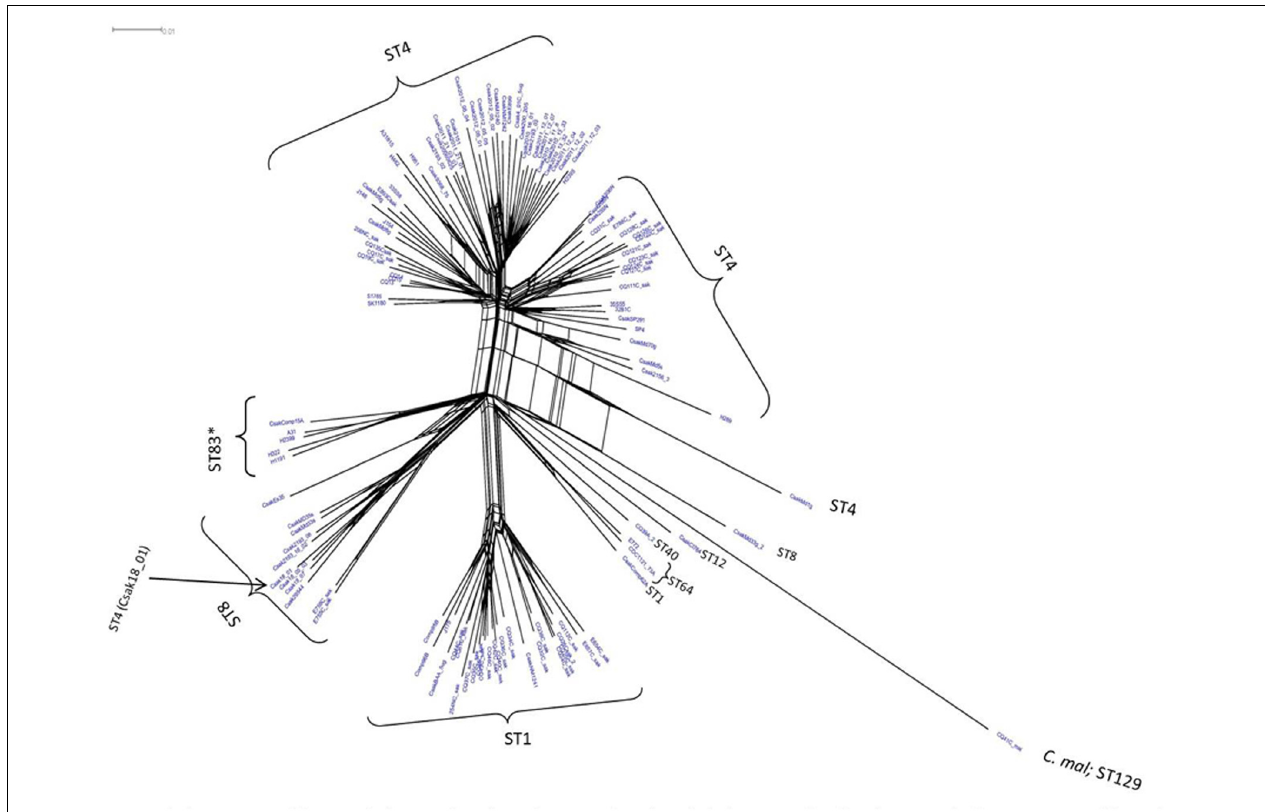
FIGURE 1 | Phylogenetic Neighbor Net (SplitsTree4) analysis of 114 C. sakazakii and phylogenetically related strains, which were generated from the gene-difference matrix (Supplementary Tables S1, S2) and then overlaid with sequence types (ST). The microarray experimental protocol as described by Jackson et al. (2011) and as modified by Tall et al. (2015) were used for the interrogation of the strains for the analysis. The phylogenetic tree illustrates that the Cronobacter microarray could clearly separate the strains according to species and respective ST. The ST83 strains ( ∗ ) clustered together along with a single ST83 strain which was obtained from an United States diary powder manufacturing facility. Bar marker represents 0.01 gene